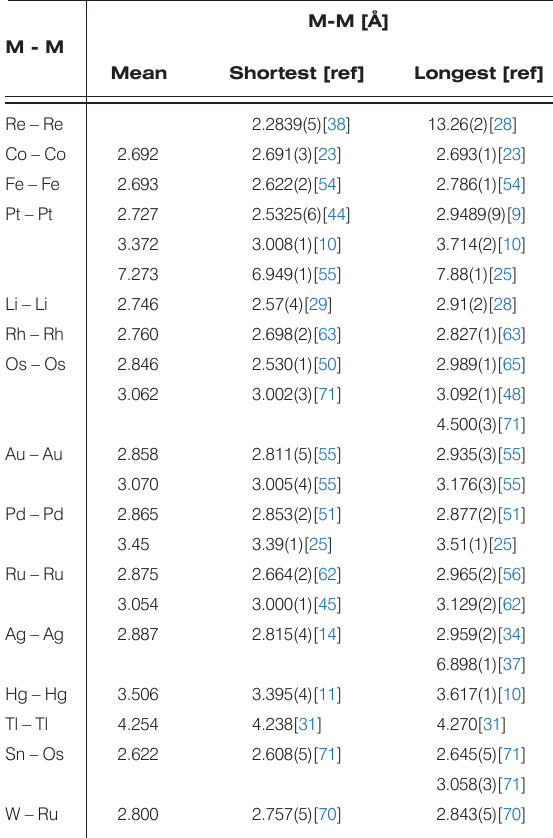
Table 5. Summary of the mean M-M and M-M´ distances in heterohexanuclear platinum clusters. M-M